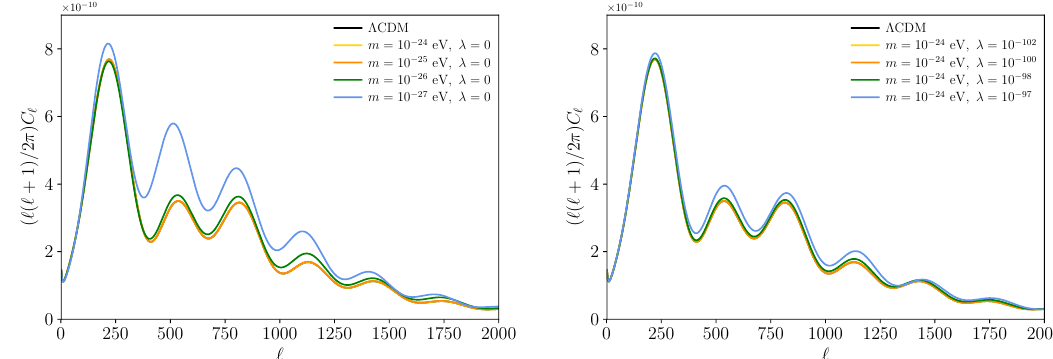
Figure 2 . Temperature power spectrum. On the left, results for a massive scalar (cid:12)eld without self-interaction. On the right, results for di(cid:11)erent self-interaction strengths for a mass that is indistinguishable from CDM with (cid:21) = 0.